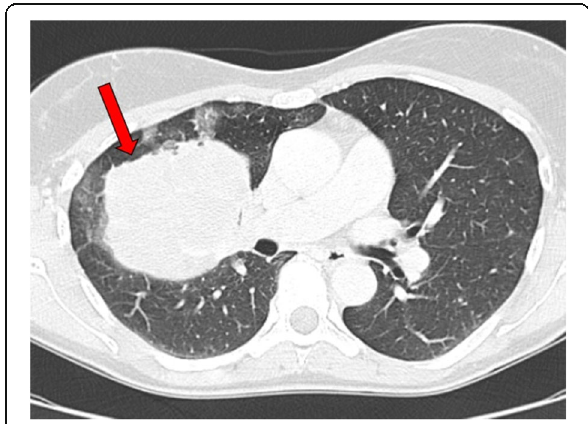
Fig. 1 CT scan of chest performed in October 2014 because of the persistence of chronic cough, showing a mass of 90 mm in the right upper lobe (case report